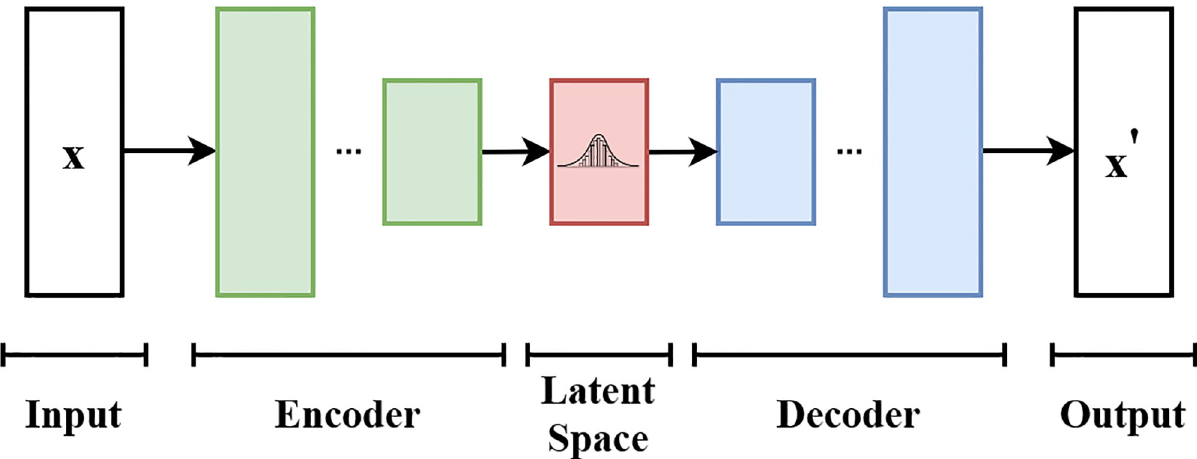
Fig 2. Schematic architecture of a variational auto-encoder. The input X is compressed by the encoder layer (green) into a hidden representational layer (red). A decoder (blue) takes as input the compressed representation and attempts to reproduce the original input as closely as possible (X’). Credit:EugenioTL, Wikipedia Commons contributor (CC BY-SA